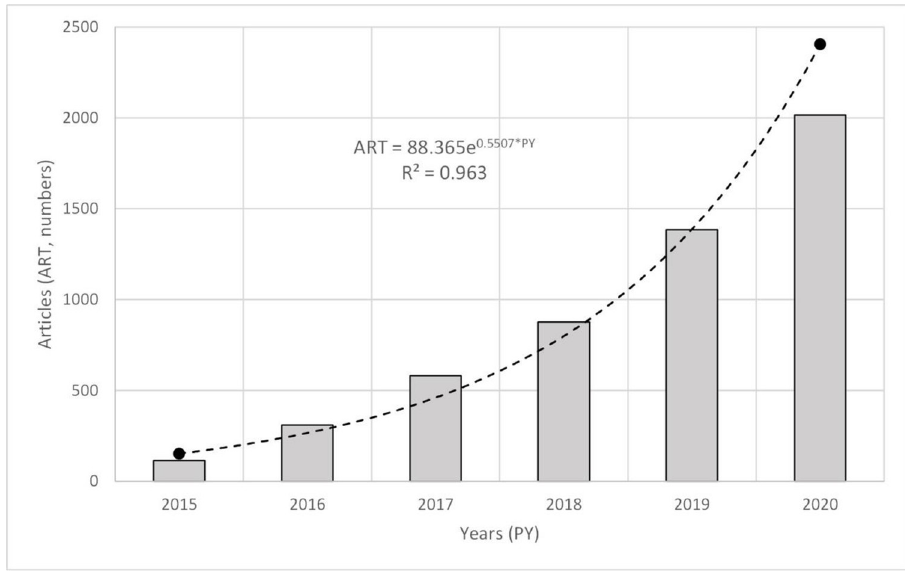
Fig 1. Academic production annual growth, data source WoS,